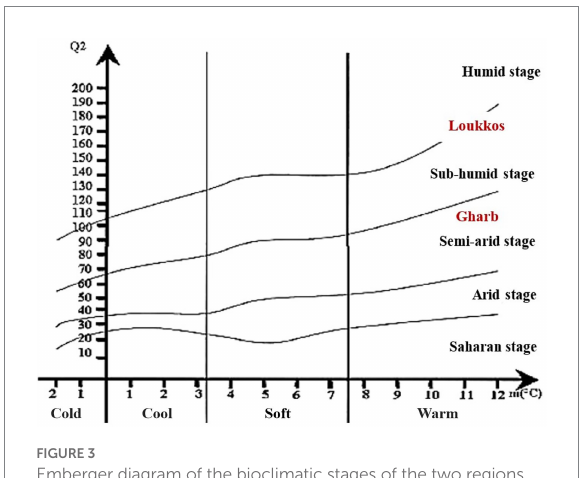
FIGURE 3 Emberger diagram of the bioclimatic stages of the two regions Gharb and